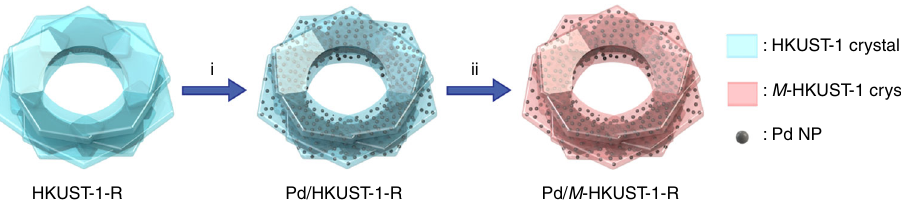
Fig. 1 Schematic illustration of the stepwise preparation of Pd/ M -HKUST-1-R. HKUST-1-R undergoes an in situ reduction of Pd 2 + to form Pd/HKUST-1-R (step i) and subsequent cation exchange with M n + (where M n + = Ce 3 + , Co 2 + , Ni 2 + , Cu 2 + , Mg 2 + , Li + , Na + or K + ) forms Pd/ M -HKUST-1-R (step